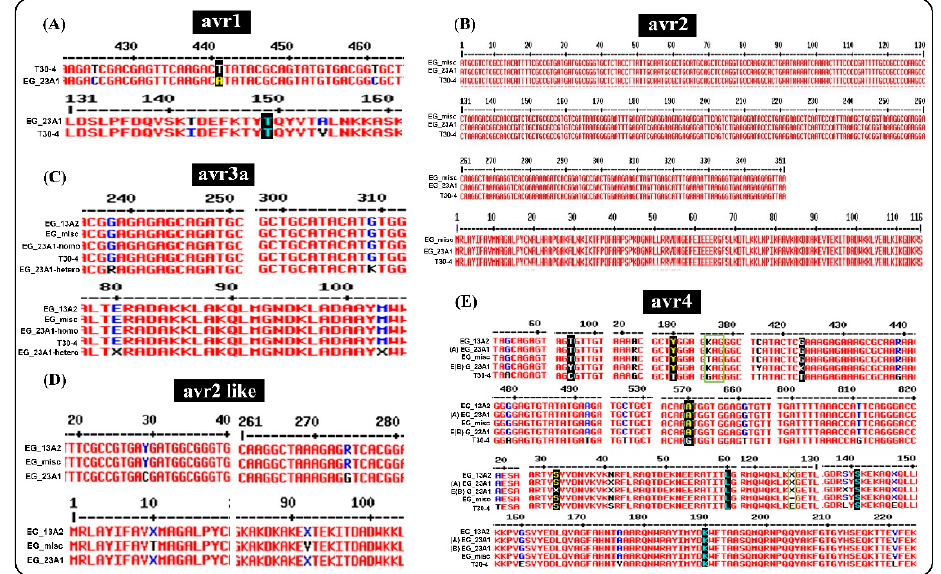
Figure 6. Partial alignments indicating locations of SNPs in the five effector genes of isolates of P. infestans ; avr1 ( A ), avr2 ( B ), avr3a ( C ), avr2 like, ( D ) and avr4 ( E ). Synonymous mutations within the Egyptian isolates are represented with the black background both for nucleotide and amino acid, while green line box refers to stop codon and truncation at position 126 of AA in the avr4 protein. An X in the amino acid sequence refers to a heterozygous non-synonymous change. Table 6. Screening of five RxLR effector genes to identify the presence and type of SNPs in two clonal lineages of P . infestans isolates.